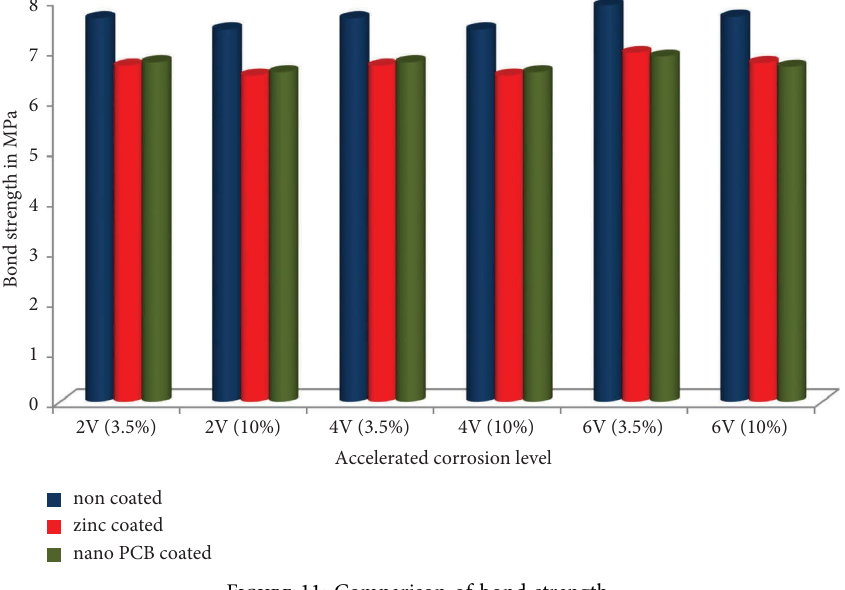
Figure 11: Comparison of bond strength. Table 5: Cost analysis for normal anticorrosive paint with prepared zinc and nano PCB-coating. SI.